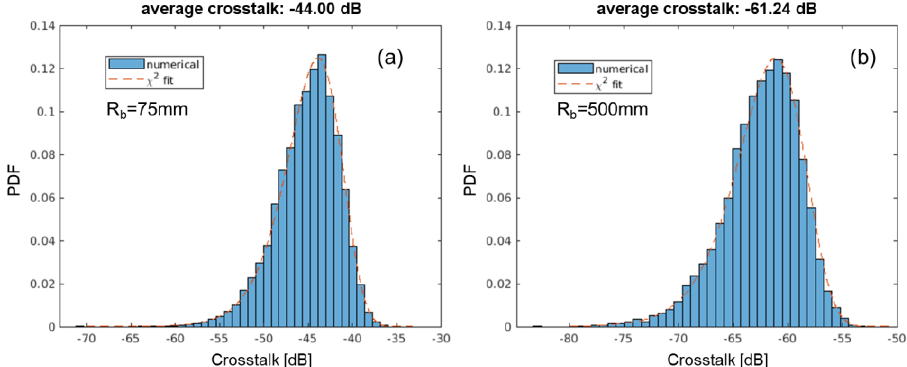
Figure 10. Probability density functions of two-core heterogenous MCF ( n eff = 5 × 10 − 4 ), computed numerically for deployments with bend radii ( a ) R b = 75 mm and ( b ) 500 mm. Dashed lines show the fit of χ 2 -distribution function with four degrees of freedom to numerical data.